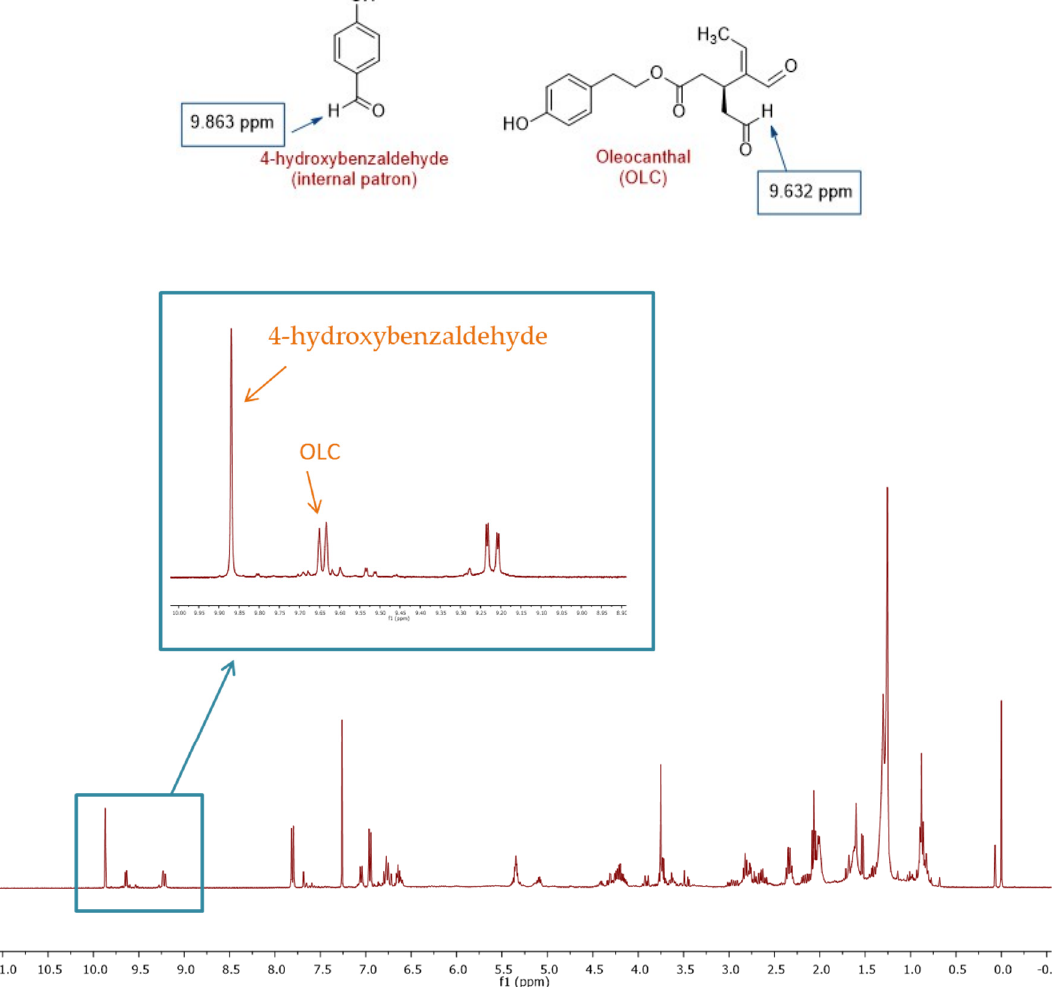
Figure 2. 1 H NMR spectrum of EVOO acetonitrile extracts recorded in CDCl 3 and using 4- hydroxybenzaldehyde as the internal standard. The signals of the OLC and internal standard are shown in the expanded